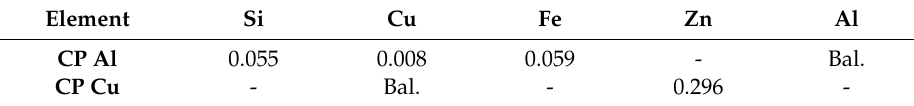
Table 1. Composition of the pure elements in